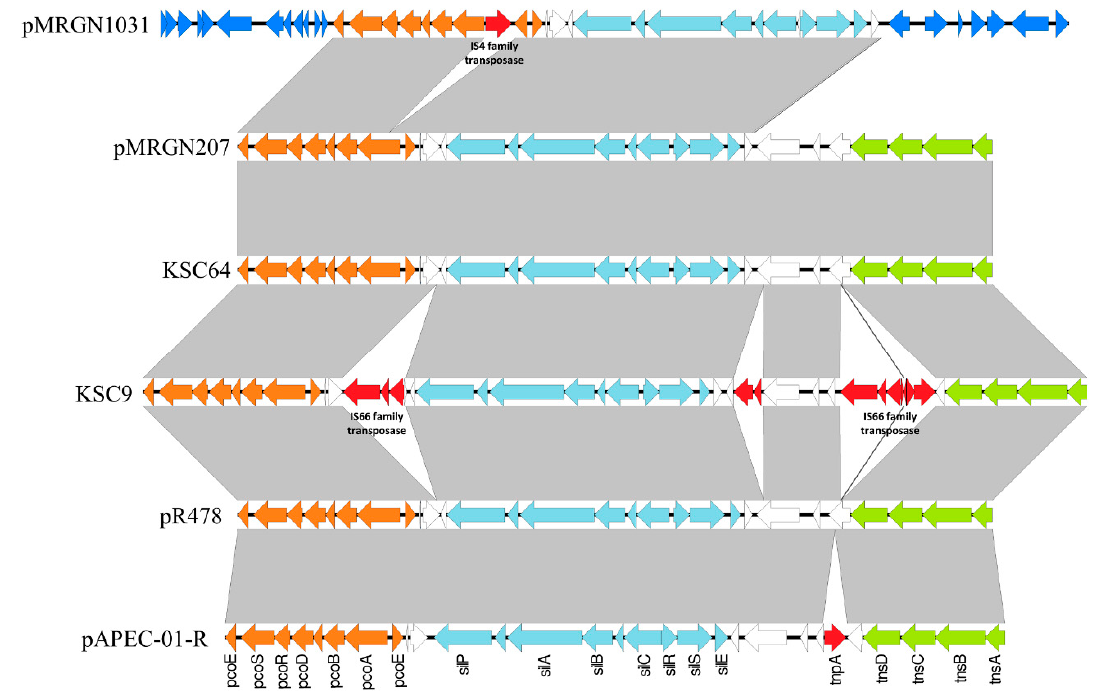
Figure 3. Genetic context of the pco – sil – tns area of four isolates from this study sequenced by PacBio. KSC1031 (plasmid pMRGN1031; GenBank accession number CP019561), KSC207 (plasmid pMRGN207; CP019559), KSC64 (CP018840), and KSC9 (CP018323) were compared to the pR478 (BXX664015) and pAPEC-O1-R (DQ517526) previously published sequences. Colors indicate the pco operon (orange), the sil operon (light blue), transposases (red), Tn 7 genes (green), and others (dark blue).